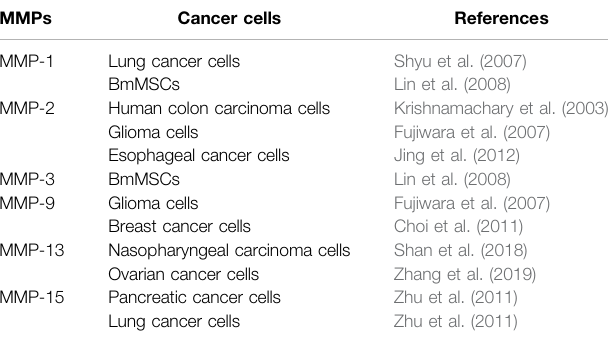
TABLE 2 | MMPs inducible by HIF-1 α